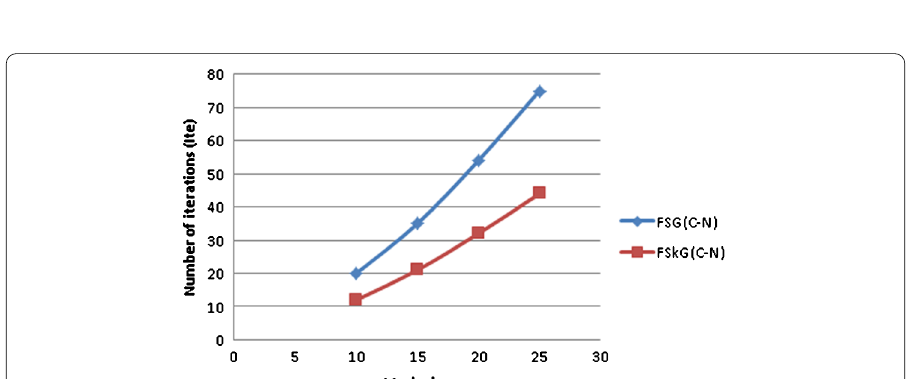
Here f ( x , y , t ) = sinh ( x ) sinh ( y )( β 2 cos ( t ) – 2 δ sin ( t ) – 3 cos ( t )) and the exact analytical solu- tion is u ( x , y , t ) = cos ( t ) sinh ( x ) sinh ( y ). Let β = 5 and δ = 10 in f ( x , y , t ), in solving the above